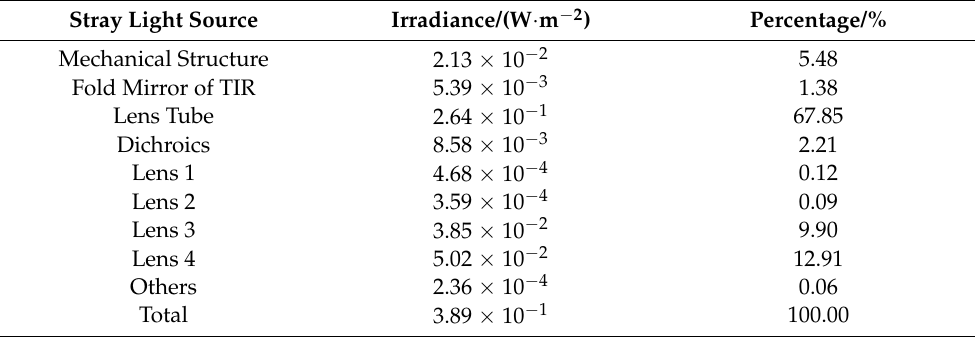
Table 3. Irradiance received by the TIR detector. Stray Light